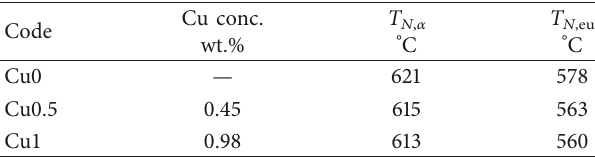
Table 2: Characteristic temperatures for the nucleation ( T the α -Al phase in A356 alloys and start of main eutectic reaction ( T N ,eu